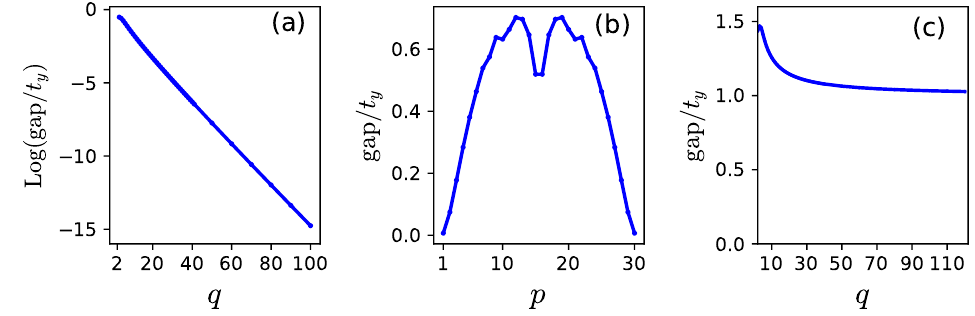
Figure 9: (a) The logarithm of the bulk energy gap (computed numerically), corre- sponding to a WSM region at B = 0, plotted as function of q , for a fixed value of p = 1, shows the exponential fall as e − η 1 q , with a constant η . The parameters are 1 = 0.9 t M = 1.8 t , t correspond to the point p in Fig. 8. (b) The bulk energy gap y x y 1 is plotted as a function of p for a fixed value of q = 31. The energy gap first increases with p and then falls again symmetrically about p ∼ q / 2. (c) Bulk energy gap plotted as function of q , for a fixed p = 1, for the point p in Fig. 8, corresponding to a LCI 2 = 0.4 t region at B = 0. The parameters are M = 1.2 t , t . The gap can be fit to y x y